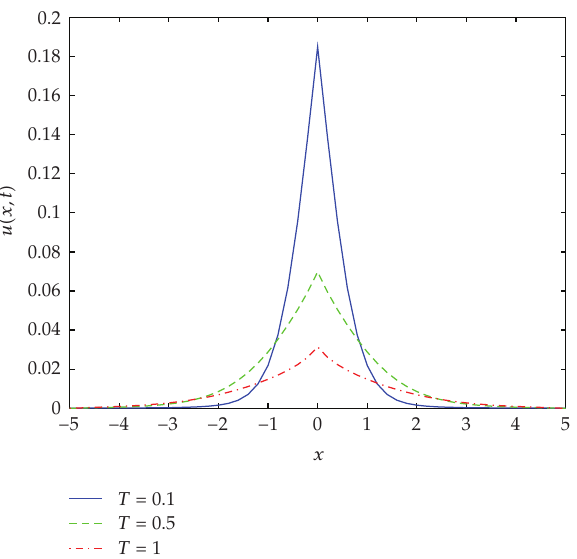
Figure 3: Numerical solutions for Example 5.2 with α (cid:7) 0 . 8 and μ (cid:7) 1 . 8 at di ff erent times T (cid:7) 0 . 1 , 0 . 5 , 1 . 0.